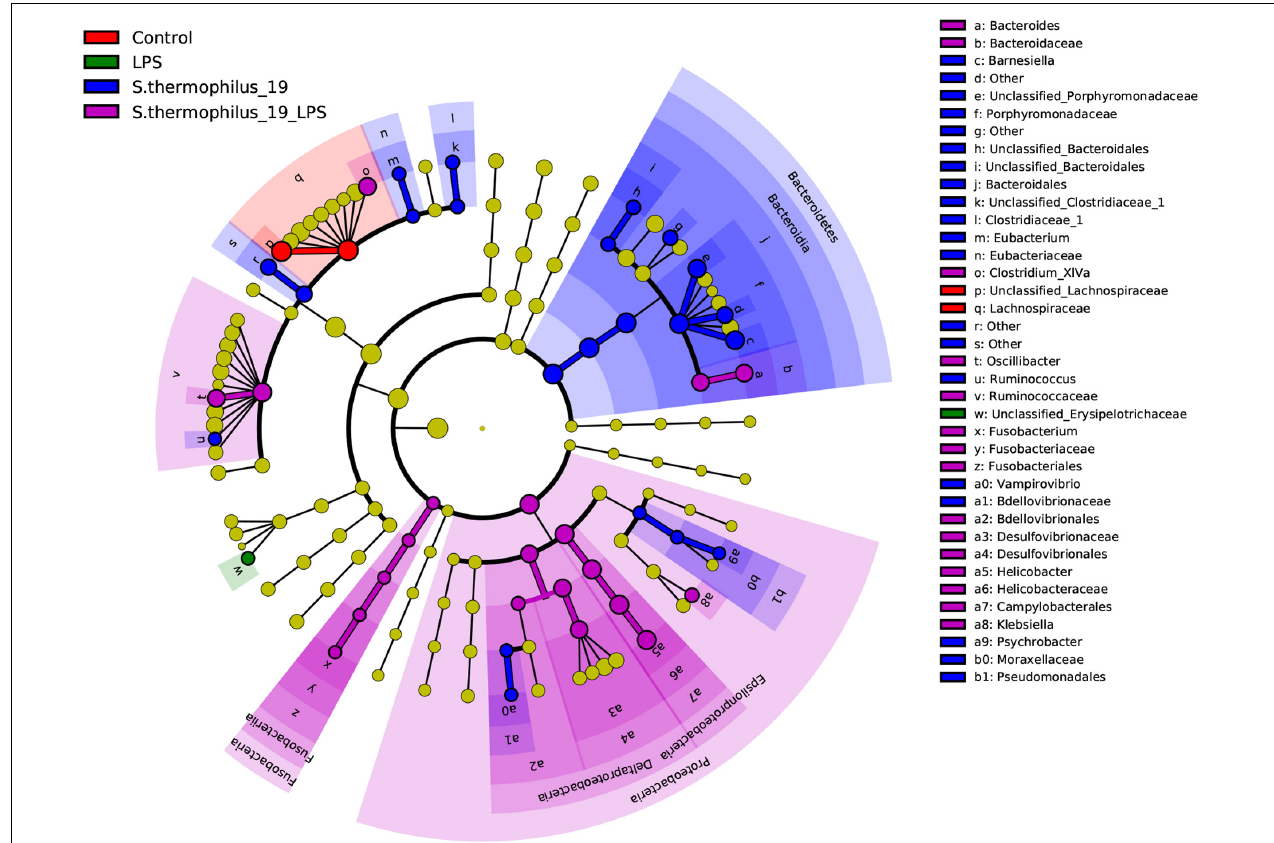
FIGURE 6 | Linear discriminate analysis effect size analyzed the differentially abundant features in the four groups. The cladograms represented here indicate the bacterial taxa that are significantly different between the four groups being compared. This analysis helps to identify a first selection of differential bacterial taxa in the considered